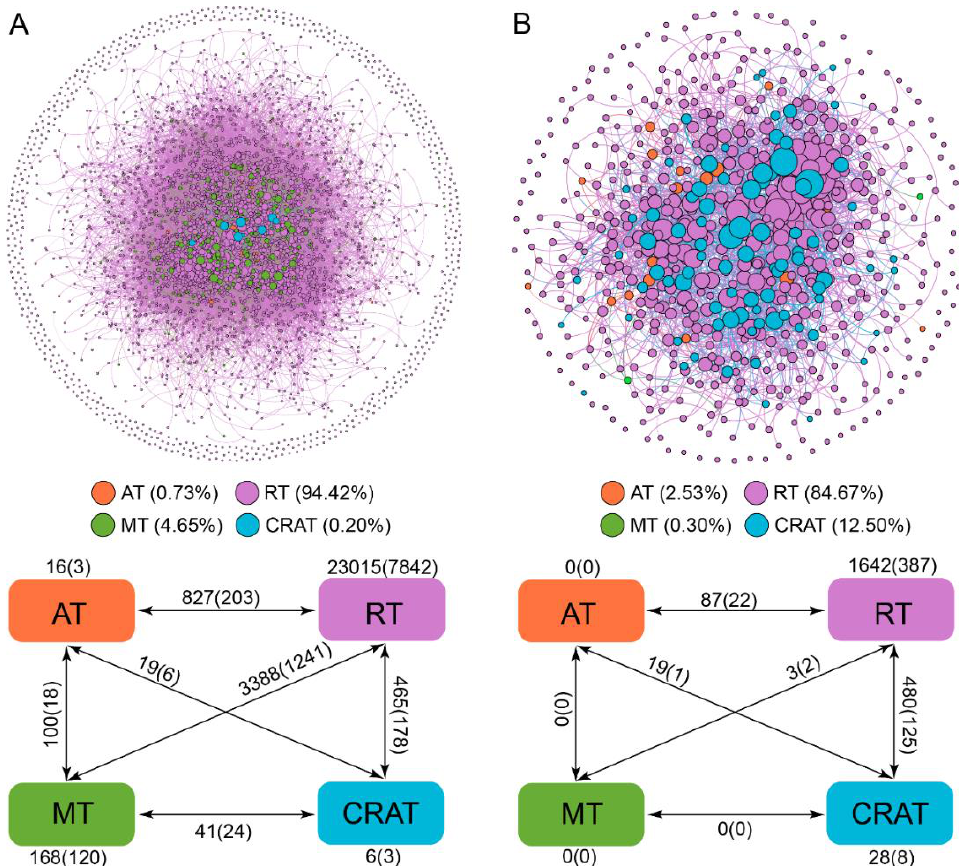
Figure 5. Co-occurring network of rhizosphere bacterial ( A ) and fungal ( B ) community within each subcommunities based on correlation analysis. The nodes in network are colored by the category of subcommunities. The size of each node in proportion to the number of connections (i.e., degree). The connections in the network indicate strong (Spearman ’s r > 0.6 or <−0.6) and significant ( p < 0.01) correlations. Numbers outside and inside parentheses represent the numbers of positive and negative edges, respectively. AT, abundant taxa (orange); RT, rare taxa (purple); MT, moderate taxa (green); CRAT, conditionally rare and abundant taxa (sky blue).